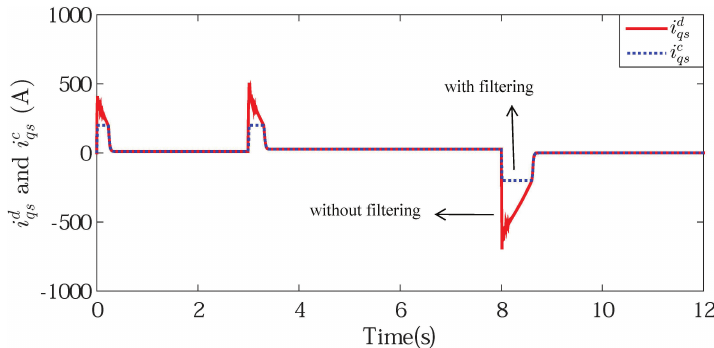
Figure 7. The q-axis current without filtering and with filtering.